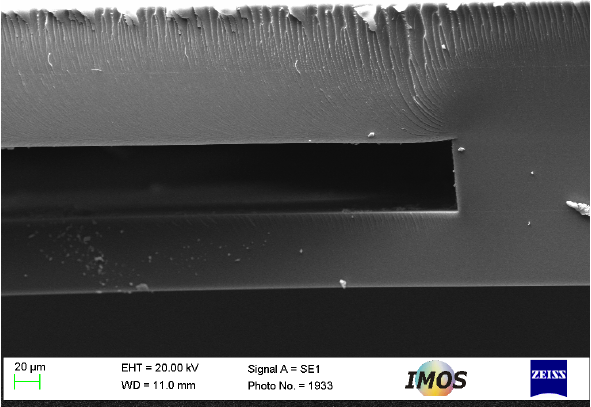
Figure 6. SEM cross-section image of a free-standing microfluidic